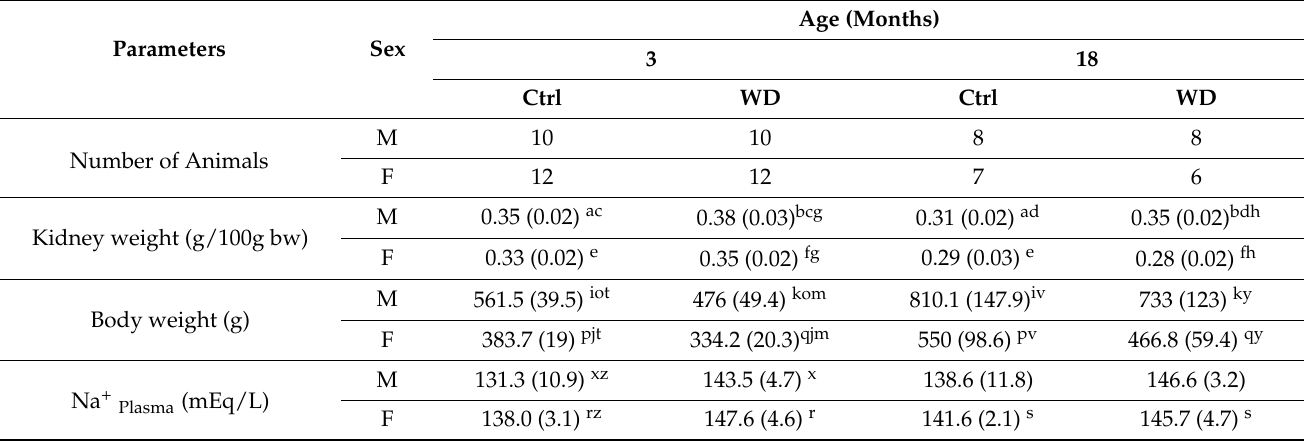
Table 1. Left kidney and body weight of normal (Ctrl) and dehydrated (WD) 3- and 18-month-old male (M) and female (F)